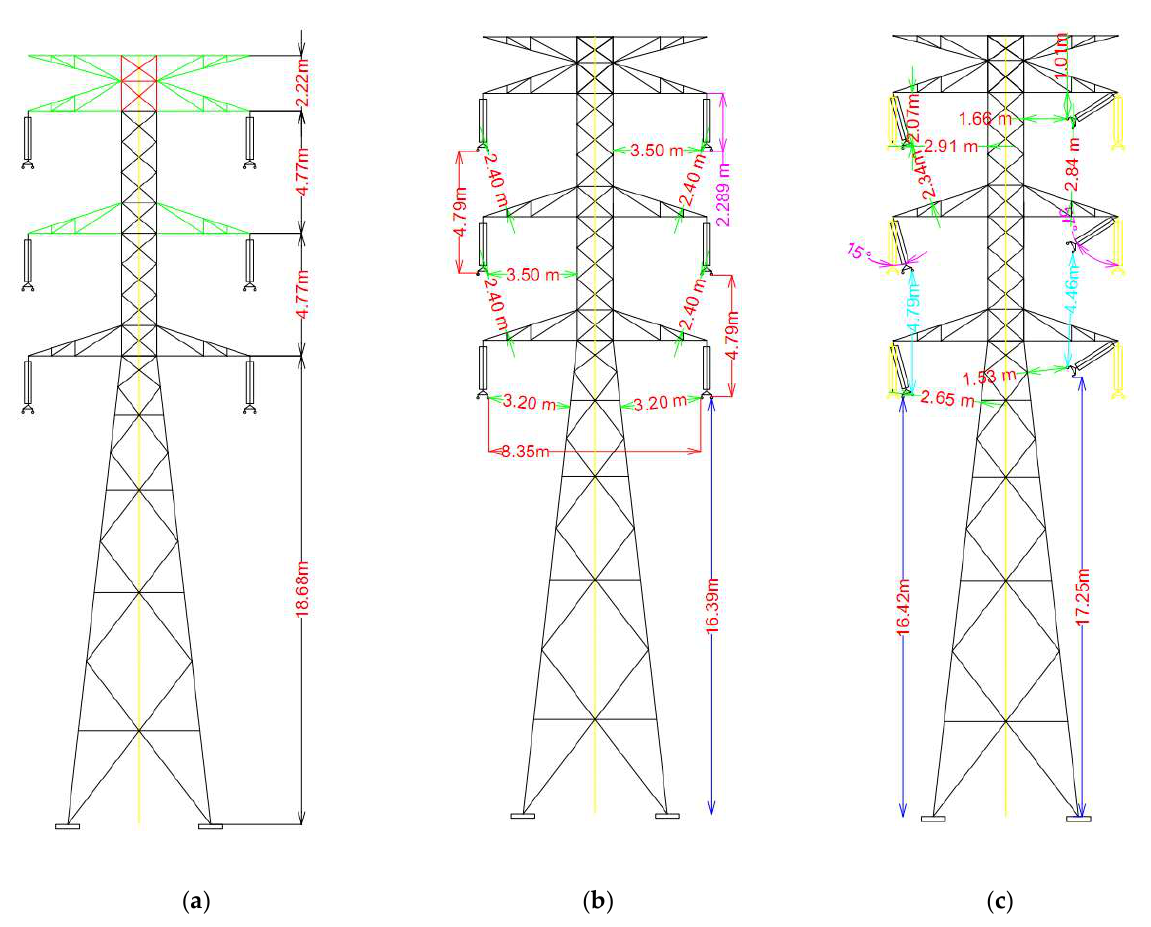
Figure 6. ( a ) The proposed model of voltage uprating for 132 kV transmission tower, ( b ) analysis of electrical clearances under still air, and ( c ) wind conditions. Table 7. Minimum electrical clearance for ( a ) still air and ( b ) wind